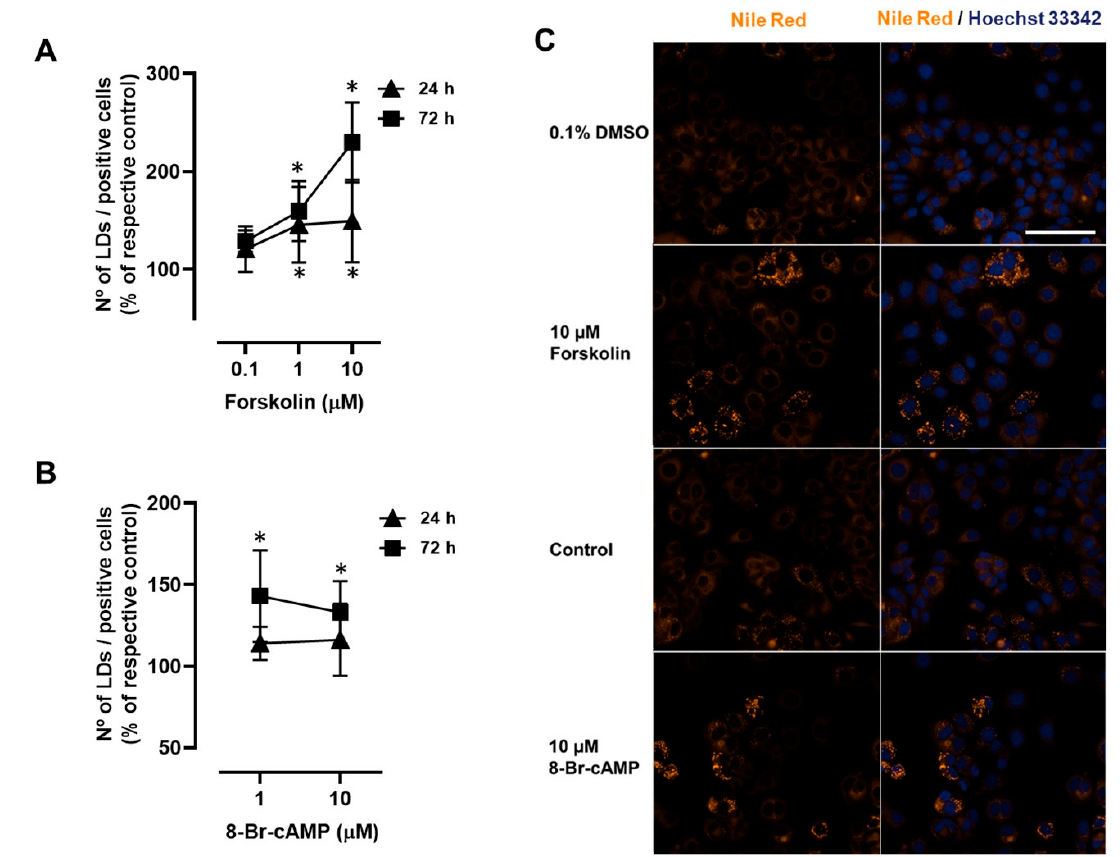
Figure 4. Influence of cAMP-elevating agents forskolin and 8-Br-cAMP on the number of lipid droplets (LDs)/positive cells in MCF-7 breast cancer cells. ( A ) Results for the number of LDs/positive cells in MCF-7 cells after treatment with forskolin (0.1 − 10 µ M) for 24 h or 72 h. ( B ) Results for the number of LDs/positive cells in MCF-7 cells after treatment with 8-Br-cAMP (1 and 10 µ M) for 24 h or 72 h. Results are expressed as percentage of control (solvent) and are presented as mean ± SD from 5 independent experiments. * p < 0.05, significantly different from solvent. ( C ) Representative microscopic images of LDs (orange fluorescence) in MCF-7 breast cancer cells without any treatment and after treatment, for 72 h, with either 10 µ M forskolin or 10 µ M 8-Br-cAMP. Nuclei (blue fluorescence) were labelled with Hoechst 33342. Scale bar: 100 µm.